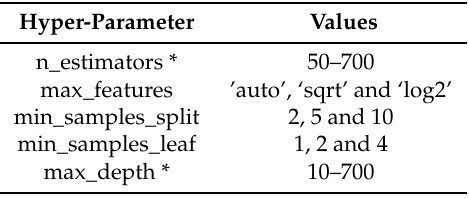
Table 1. Grid of the hyper-parameters used for a 3-fold cross-validation.